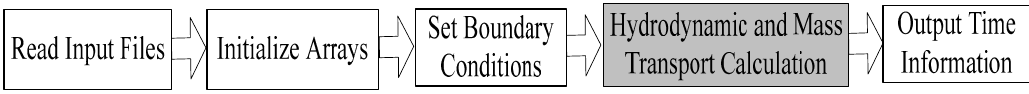
Figure 2. Flowchart of EFDC model (shaded boxes indicate the calculation process for the hydrodynamic variables of interest for data assimilation).